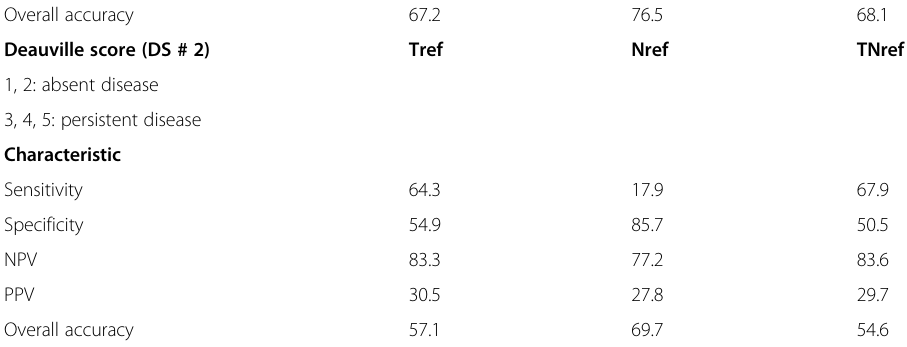
Table 4 Overall diagnostic accuracy using standardized reporting criteria (Deauville, Hopkins, and Cuneo scores)